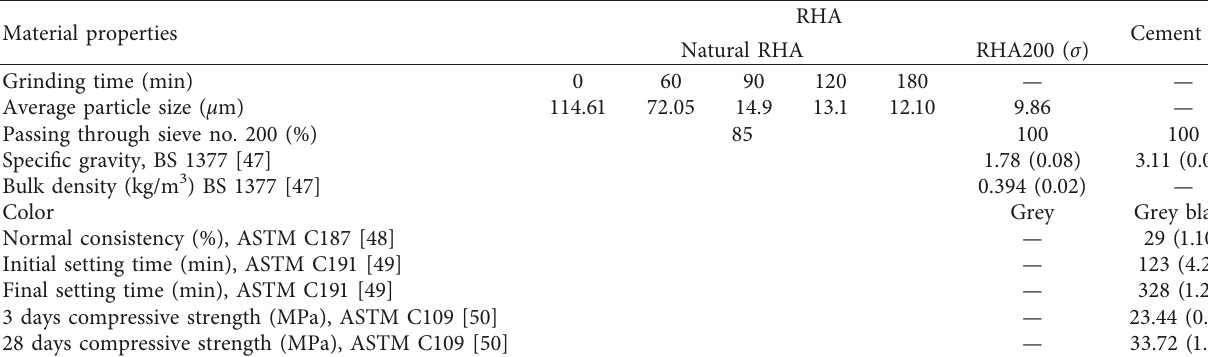
Table 2: Physical properties of RHA and